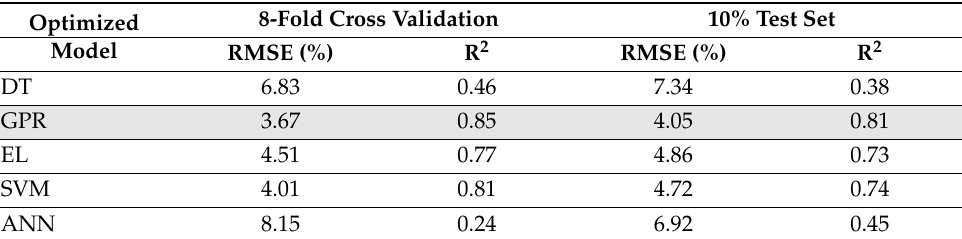
Table 6. Prediction performance of the five optimized ML models trained on the SAE-based aug- mented dataset for soil moisture retrieval. Performance metrics are measured over an eight-fold cross validation scheme and for 10% holdout test set. The entries of the best performing model are highlighted in grey